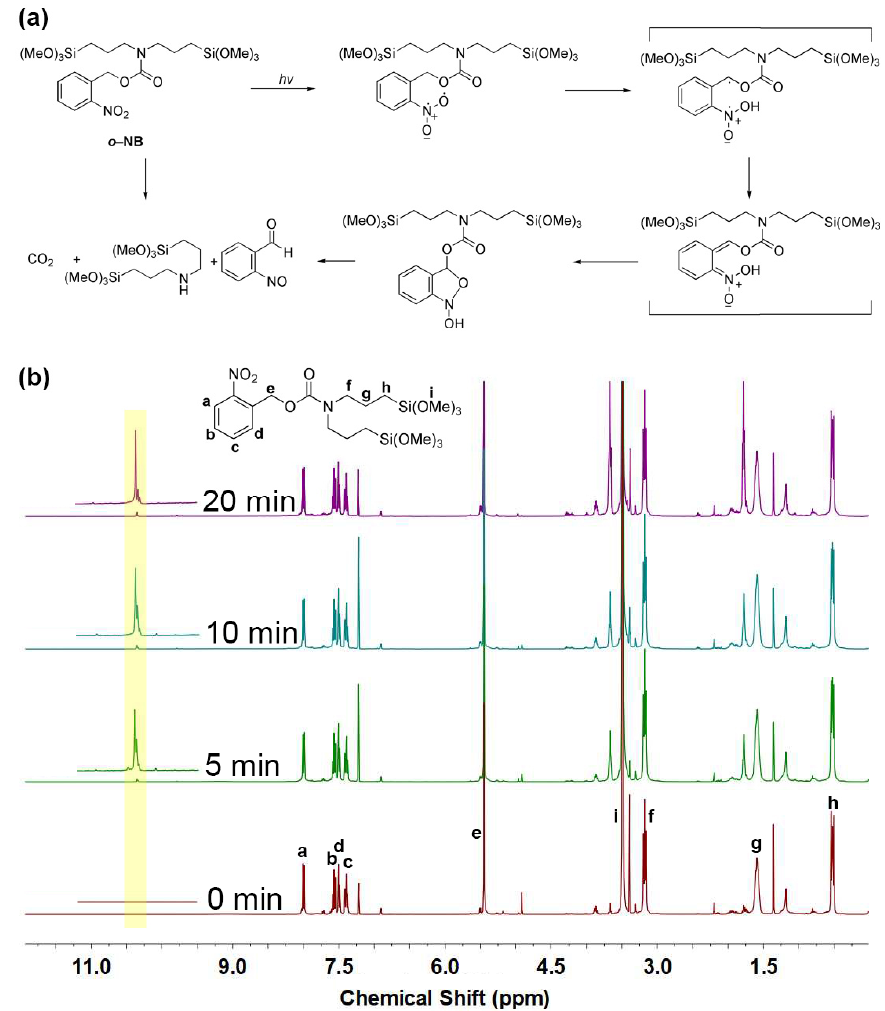
Figure 1. ( a ) The photolysis mechanism of o –NB upon irradiation at 254 nm. ( b ) Comparison of the 1 H NMR spectra of o –NB after irradiation 0, 5, 10, and 20 min, depicting its photoresponsive behavior with the disappearance of the benzyl peak at 5.4 ppm (Ph– CH 2 –).